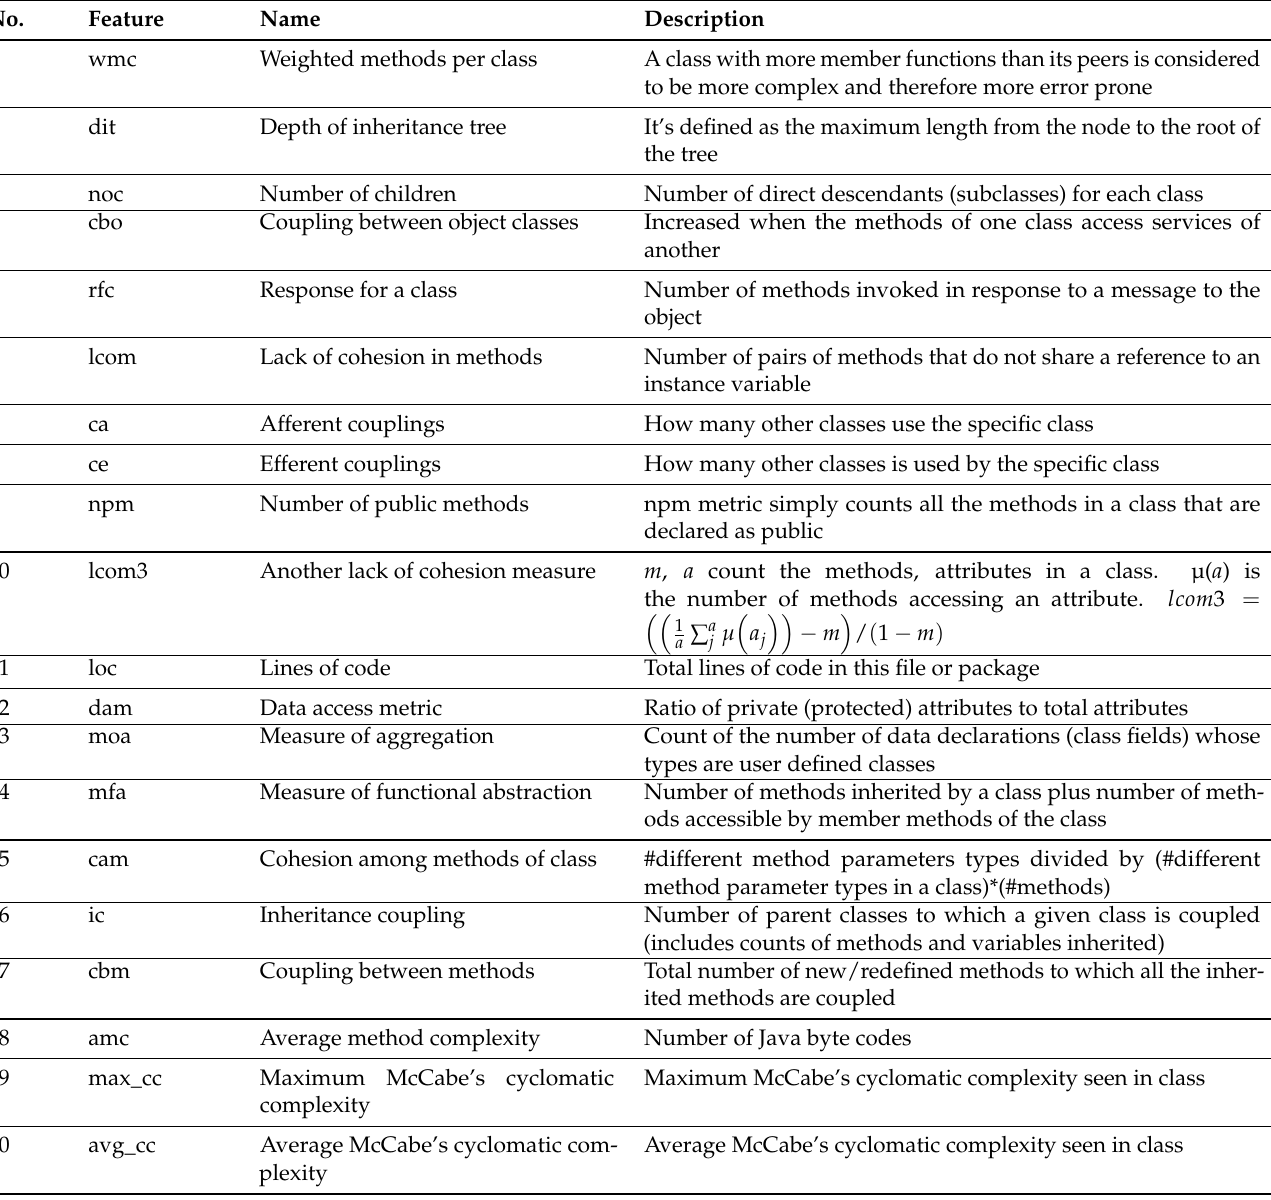
Table 2. The features of the